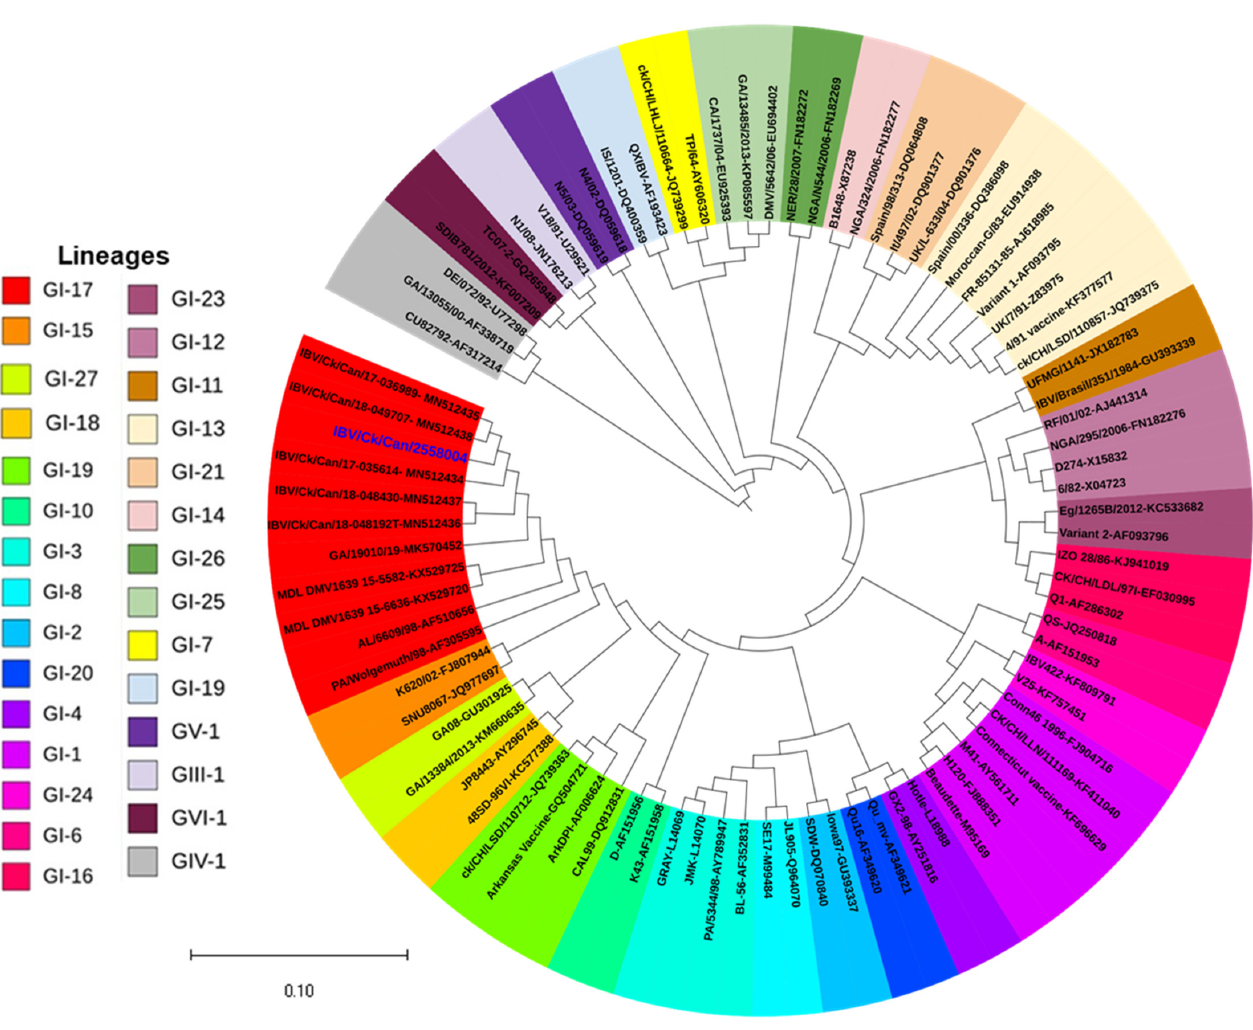
Figure 1. Phylogenetic relationships between IBV/Ck/Can/2558004 (denoted with blue color) and 85 reference strains based on the nt sequences of the S1 gene. The tree was constructed using the maximum-likelihood method and the Tamura–Nei model with 1000 bootstrap replicates in MEGA X software. Strains located within the same lineage are indicated in the same color. The constructed tree was viewed by iTOL software.